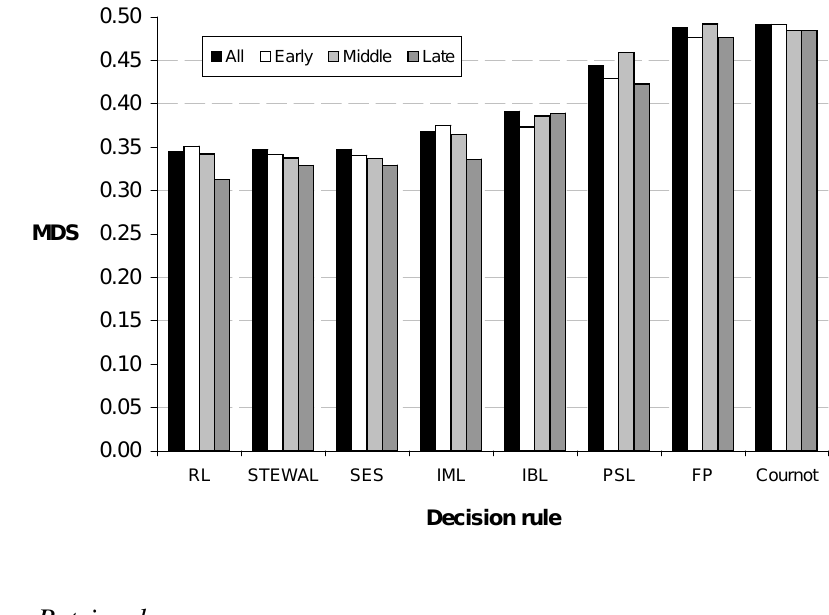
Figure 3. Mean deviation scores averaged over all 108